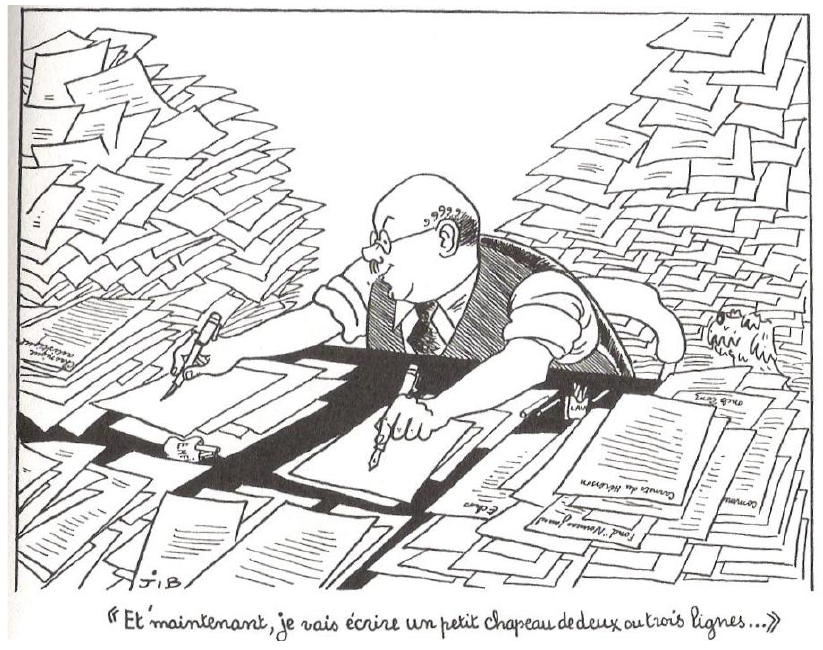
Fig. 1 Cartoon of Paul Colin, Le nouveau journal (31 August